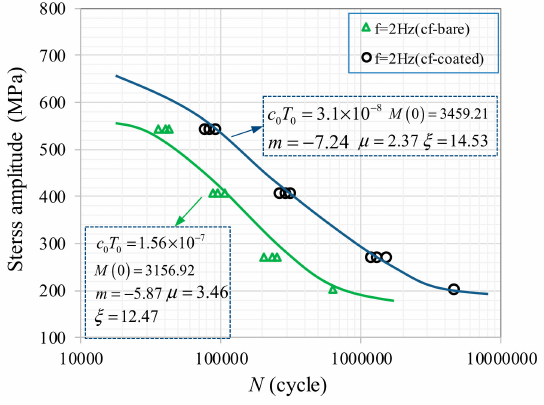
Figure 10. Regression results in corrosion fatigue damage evolution